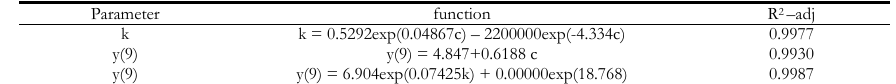
Relationship among LINEX